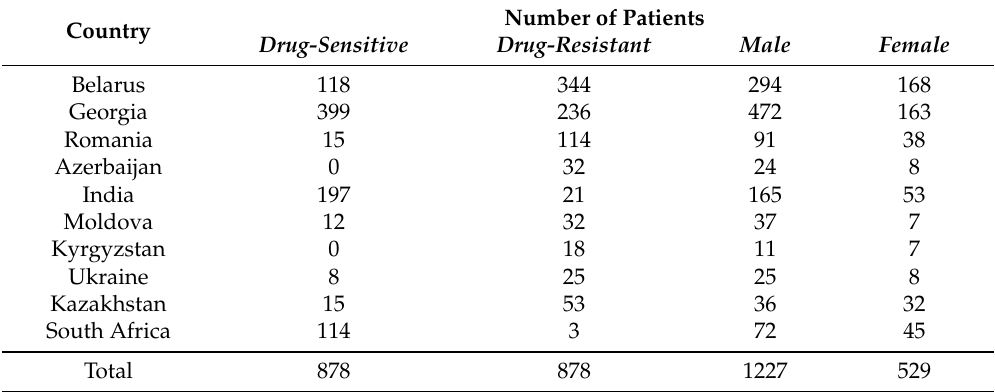
Table 1. Patient distribution from different countries and genders for the chest X-ray data used in this